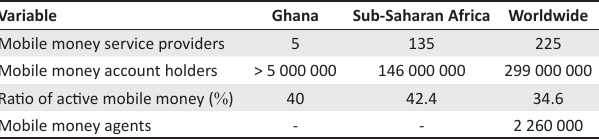
TABLE 1: Mobile money industry